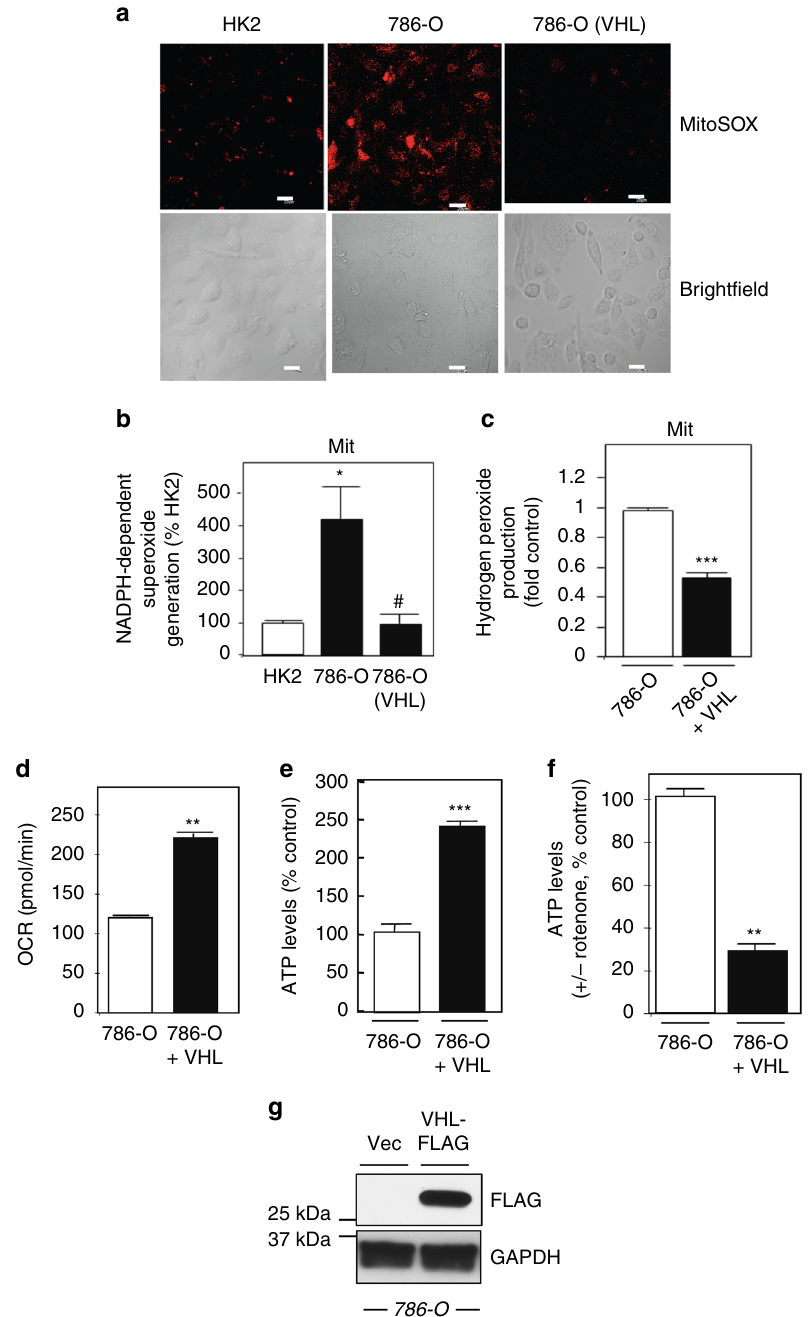
Fig. 3 Redistribution of mitochondrial ATP levels correlates with NOX activation. a Superoxide generation within the mitochondrial compartment was examined in normal HK2 and RCC 786-O with and without VHL using MitoSOX Red fl uorescence and confocal microscopy. Bright- fi eld microscopy is shown (lower panel), scale bar 20 μ M. b NADPH-dependent superoxide generation was examined as a readout of NOX activity in the mitochondrial fraction prepared from normal HK2 and RCC 786-O with and without VHL. c Hydrogen peroxide was measured in mitochondrial fractions of RCC 786-O with (+) or without ( − ) VHL cells using Amplex Red reagent. The results are from at least three independent experiments and expressed as the means where ± S.E.M. * p < 0.05 compared to HK2 control, ± S.E.M. # p < 0.01 or *** p < 0.001 compared to 786-O alone. d OCR, a measurement of oxygen consumption was measured in live RCC 786-O cells with and without VHL using the Seahorse XF instrument. The data are expressed in pmol/min are representative of three independent experiments with an n = 4 for each experiment and expressed as the means using one-way ANOVA with Tukey ’ s post hoc test where ± S.E.M. ** p < 0.05 compared to RCC 786-O without VHL. e Total ATP levels were measured in RCC 786-O cells with or without VHL. f RCC 786-O cells with or without VHL were incubated, 30 min or not with rotenone (1 μ M) and total ATP levels were measured as in e . g Successful VHL overexpression was examined in TCL by western analysis using FLAG antibodies. GAPDH was probed as control. The reduction of ATP by rotenone was subtracted from buffer control and expressed as % control. The results are from at least three independent experiments and expressed as the means using one-way ANOVA with Tukey ’ s post hoc test where ± S.E.M. ** p < 0.01 and *** p < 0.001 compared to